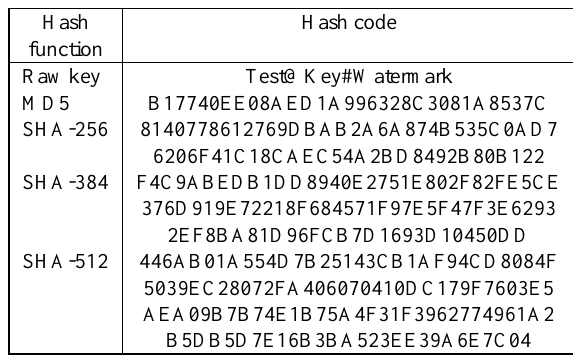
Figure 3. The example of Arnold transform for 32×32 block: a) original block, b) from left to right and from top to bottom – 24 iterations of transform.